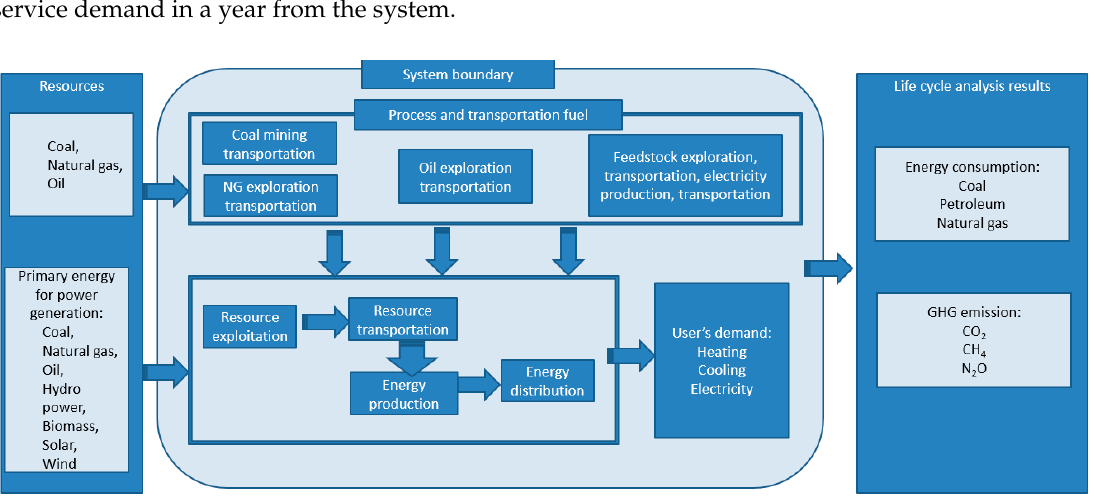
Table 3. Key variables related to LCA in this paper.